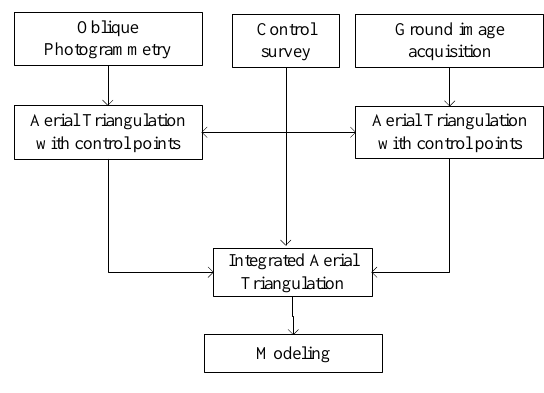
Figure 1 The integration modeling process flow chart